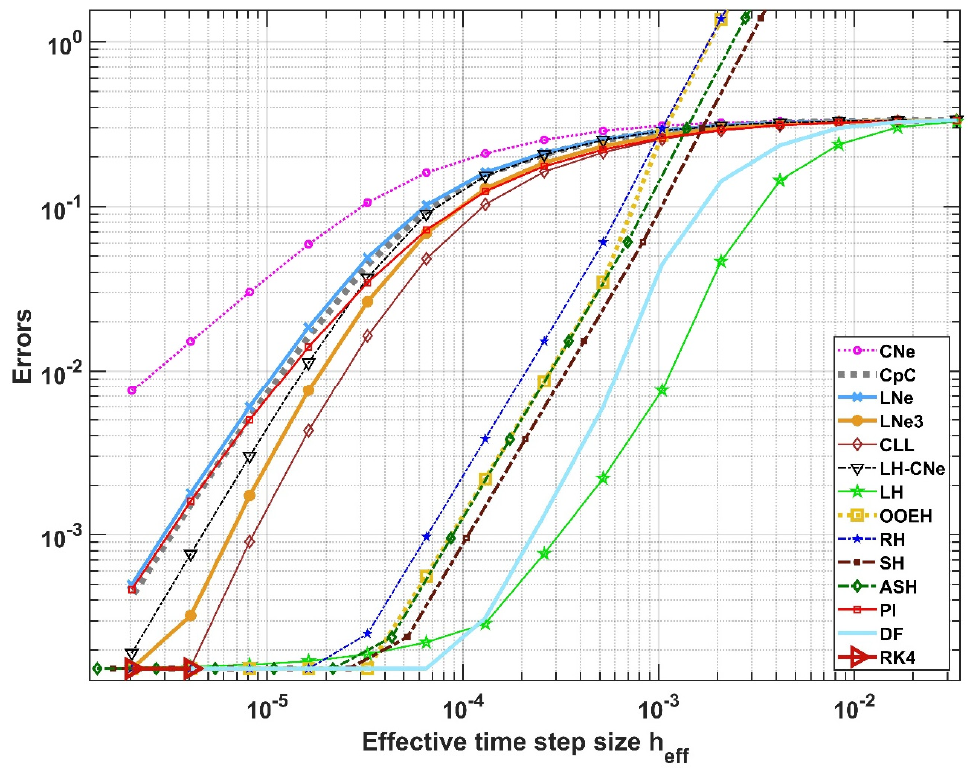
Figure 4. Errors as a function of the effective time step size h eff for Experiment 1. The errors are defined in (20), and h eff is defined in (21). The slopes of the error curves give the order of convergence of the